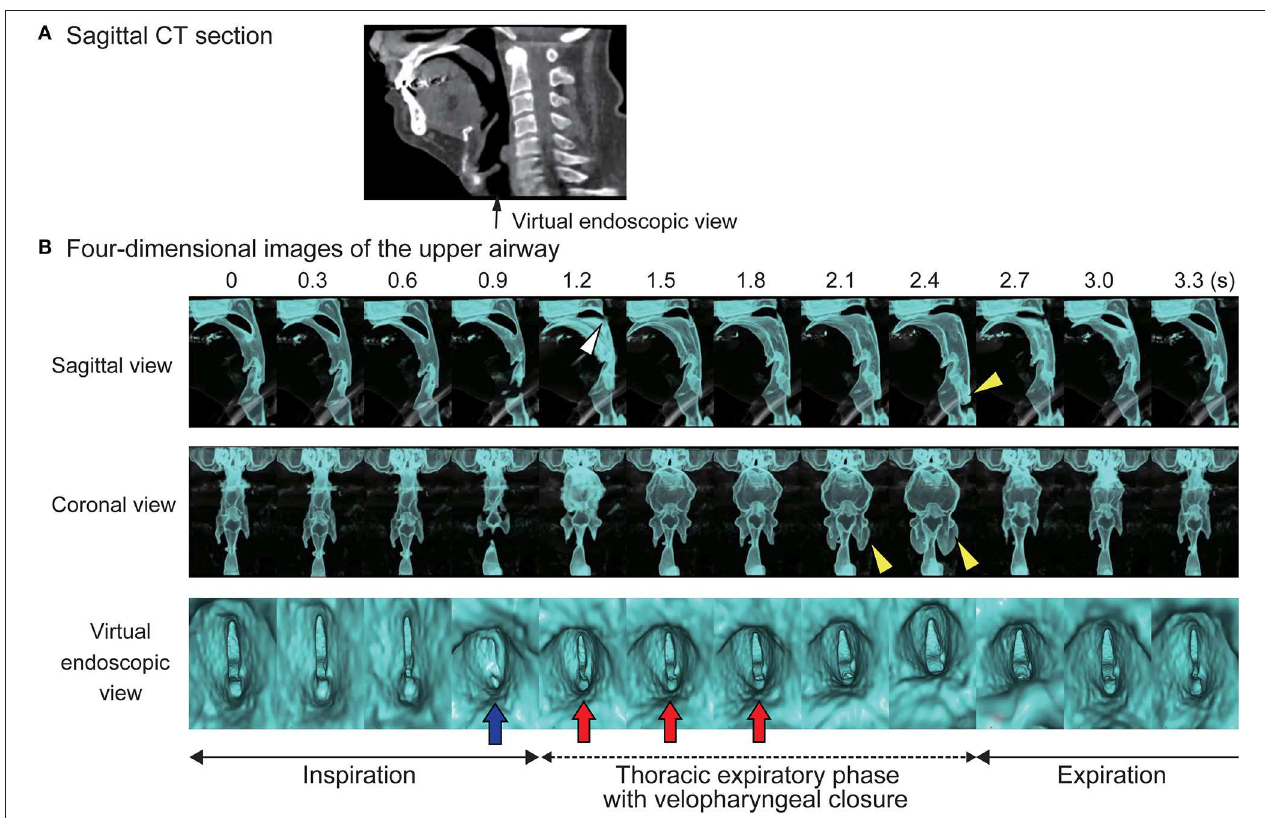
FIGURE 1 | Four-dimensional computed tomographic (4D-CT) images. (A) Sagittal section of computed tomography. (B) Serial four-dimensional computed tomographic images of upper airway during sleep shows glottis closure at a terminal stage of inspiration (blue arrow), subsequent velopharyngeal closure (white arrow head), expansion of the pharyngeal cavity (yellow arrow heads), and succeeding glottis opening with increase of pharyngeal pressure (red